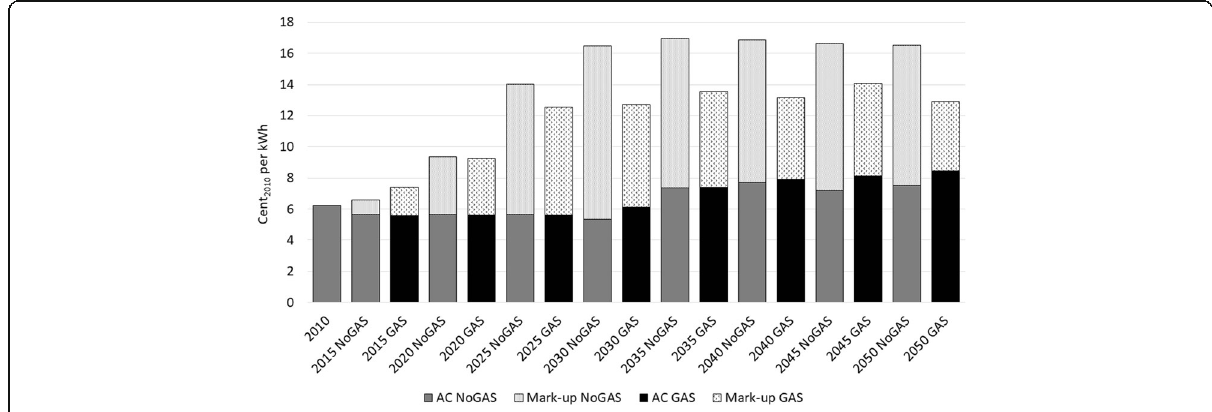
Fig. 5 Average cost and wholesale price mark-up for